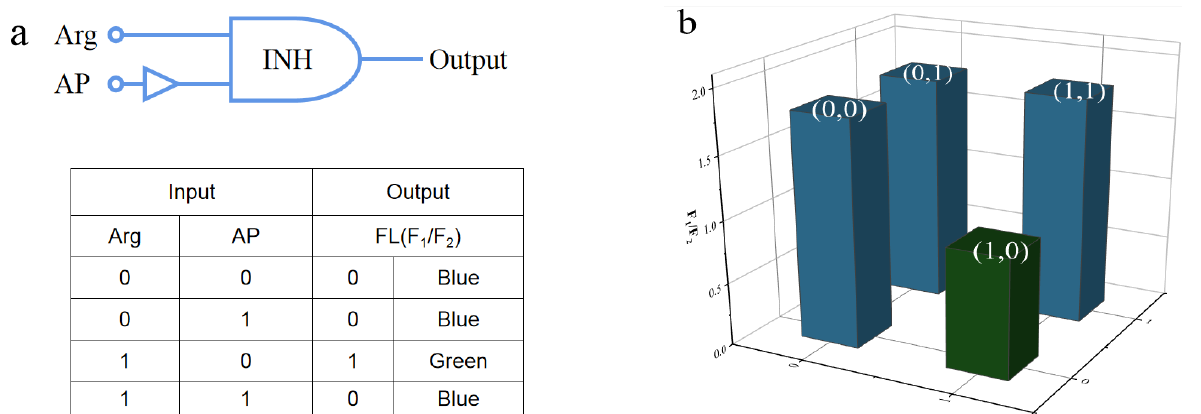
Figure 16. ( a ) Illustration of the fluorescent logic gates based on the N-CD/calcein sensor; ( b ) the histogram of logic gates with various inputs.